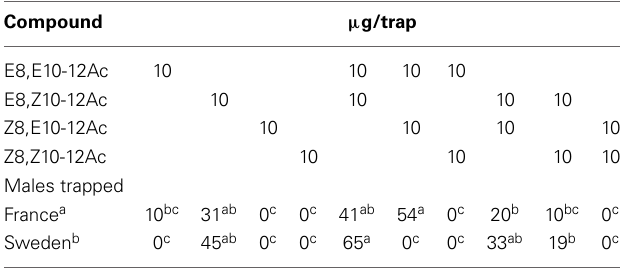
Table 2 | Field attraction of C. splendana males to the geometric isomers of 8,10-12Ac and their blends in Touraine, France and Scania,